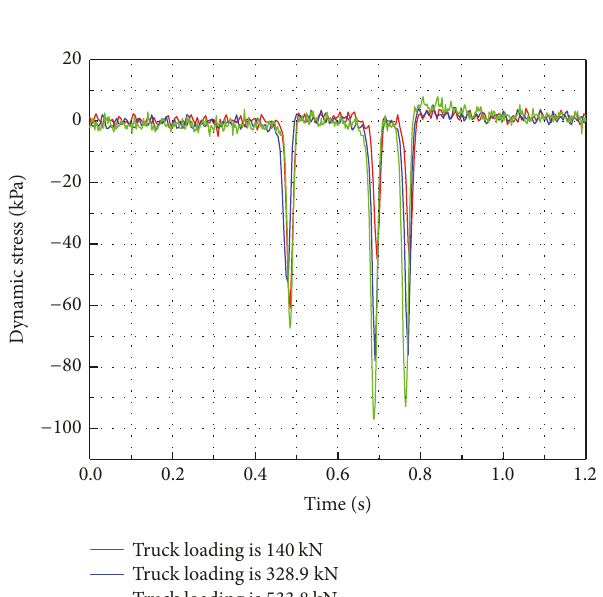
Figure 6: General situation of field monitoring.